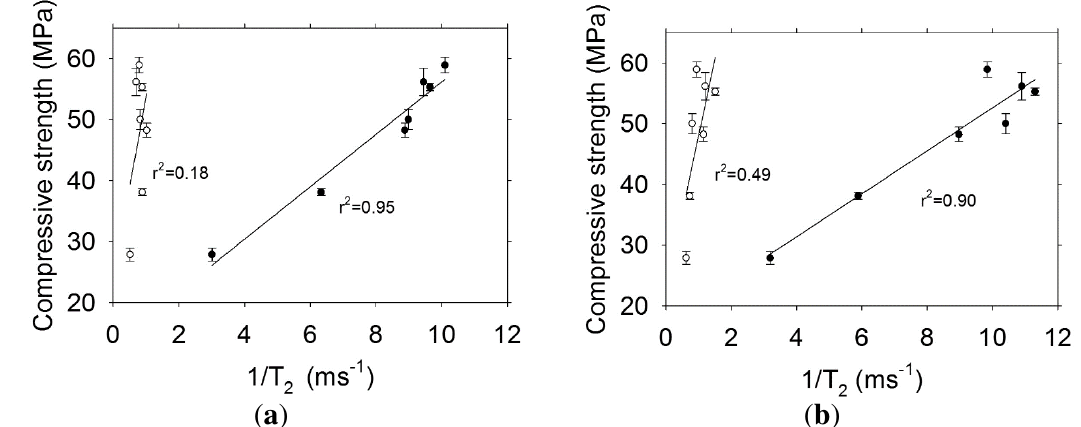
Figure 11. Transverse relaxation rate versus compressive strength for concrete w/c for ( a ) Sensor 1 and ( b ) Sensor 2 ○ Long lifetime